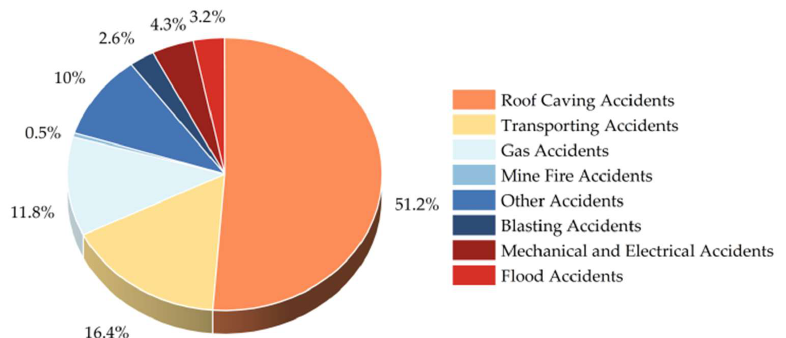
Figure 1. Proportion chart of various types of coal mine accidents.